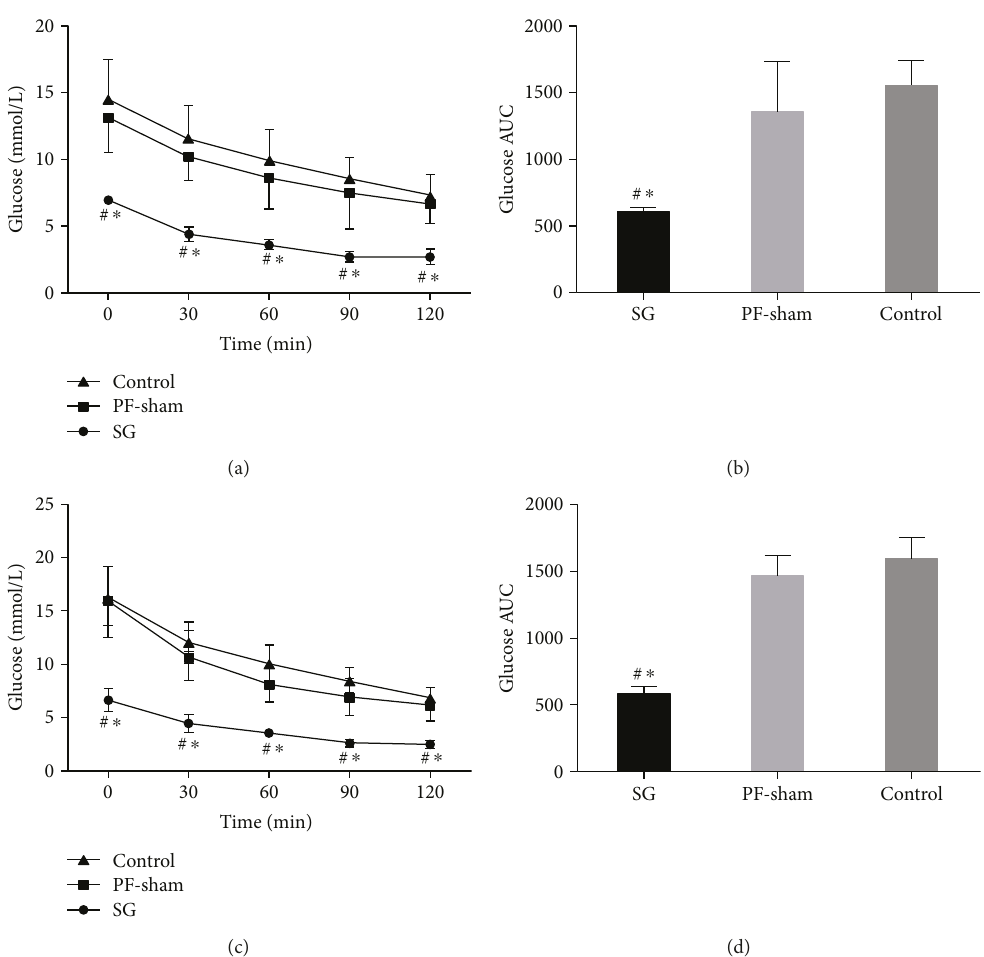
Figure 3: E ff ects of sleeve gastrectomy on insulin tolerance in GK rats. Line charts show the blood glucose (a) and the AUC (d) at 12 weeks after an IP injection of insulin. # P < 0 05 versus controls, ∗ P < 0 05 versus and the blood glucose (c) and the AUC ITT